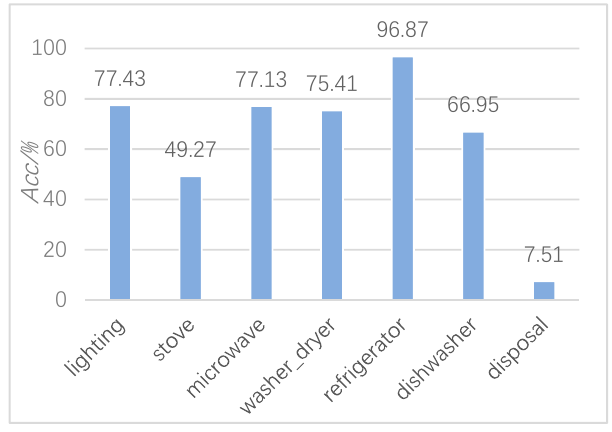
Figure 7. Seven loads’ on-duration accuracy in REDD house 2.